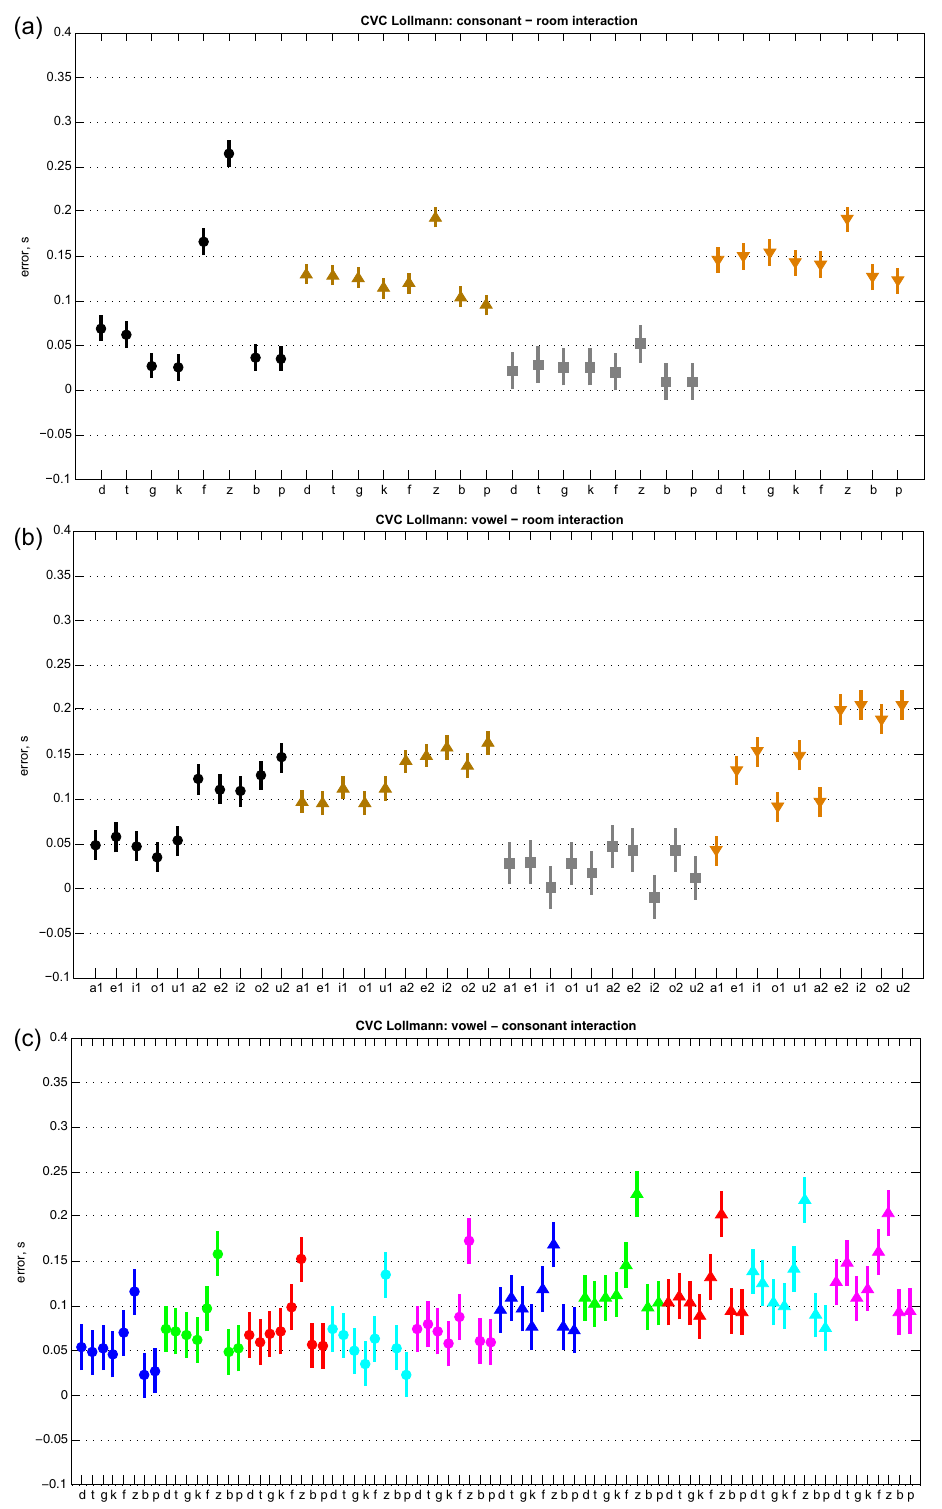
Figure 3. CVC logatomes: marginal means for Löllmann ’ s algorithm. (a) “ Consonant ” (cid:5) “ room ” interaction, (b) “ vowel ” (cid:5) “ room ” interaction, (c) “ vowel ” (cid:5) “ consonant ” interaction. For more details see Figure